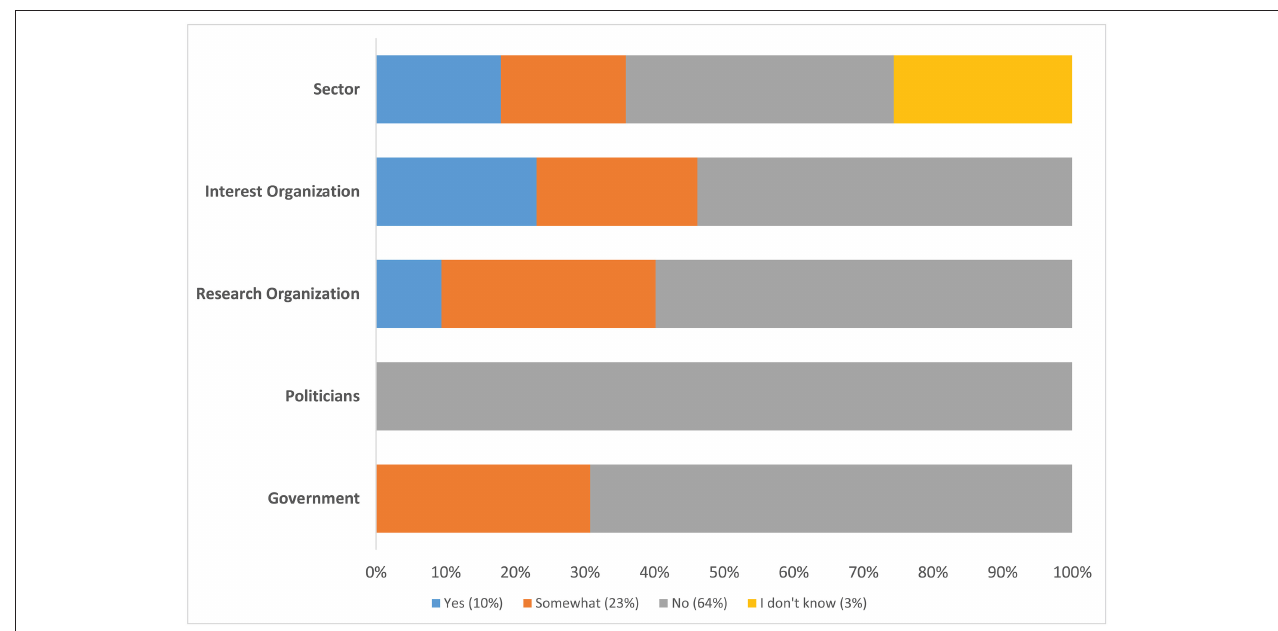
FIGURE 7 | “How aware is the public of MPs in sludge applied to agricultural land?” Percentages reported represent the frequency with which an issue was mentioned across all stakeholders responding ( n = 30).